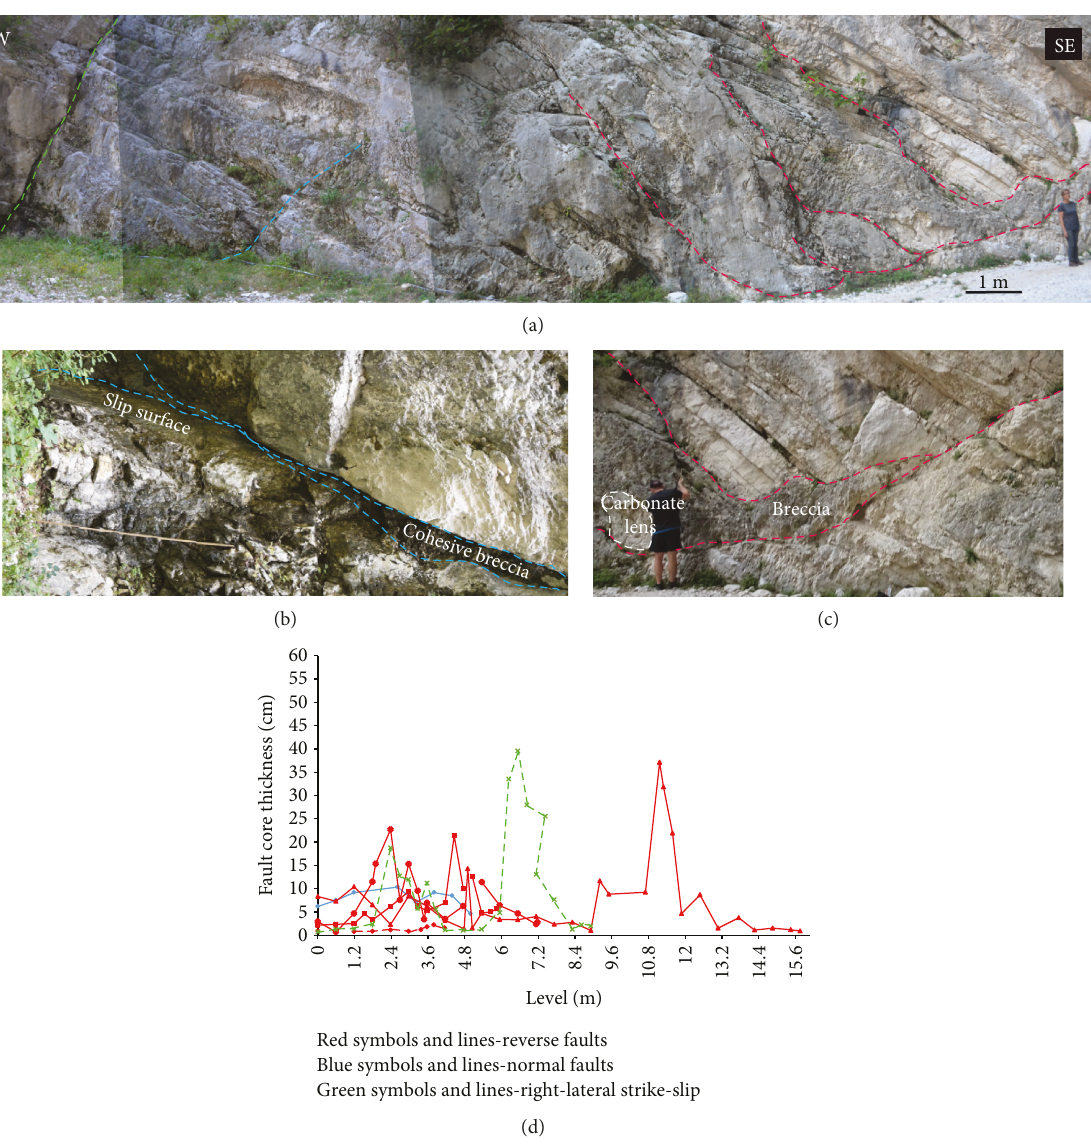
Figure 11: (a) Outcrop photo of faults measured in scanline 5 of the Vallone Santo Spirito (Maiella Mountain). There is a major reverse fault, which splays in several branches of reverse faults (shown in red dashed lines) in addition to a strike-slip fault and a normal fault. (b) A closeup picture of a pretilted normal fault in this locality. The image has been rotated 90 degrees for illustration purposes. (c) A closeup picture of the reverse fault core. (d) Fault core thickness measurements for the studied